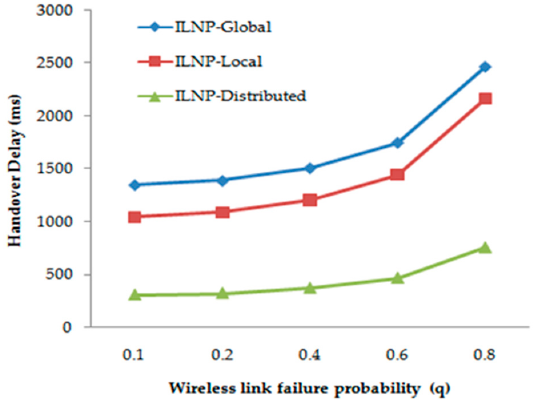
Figure 24. Impact of L wl on HOD.